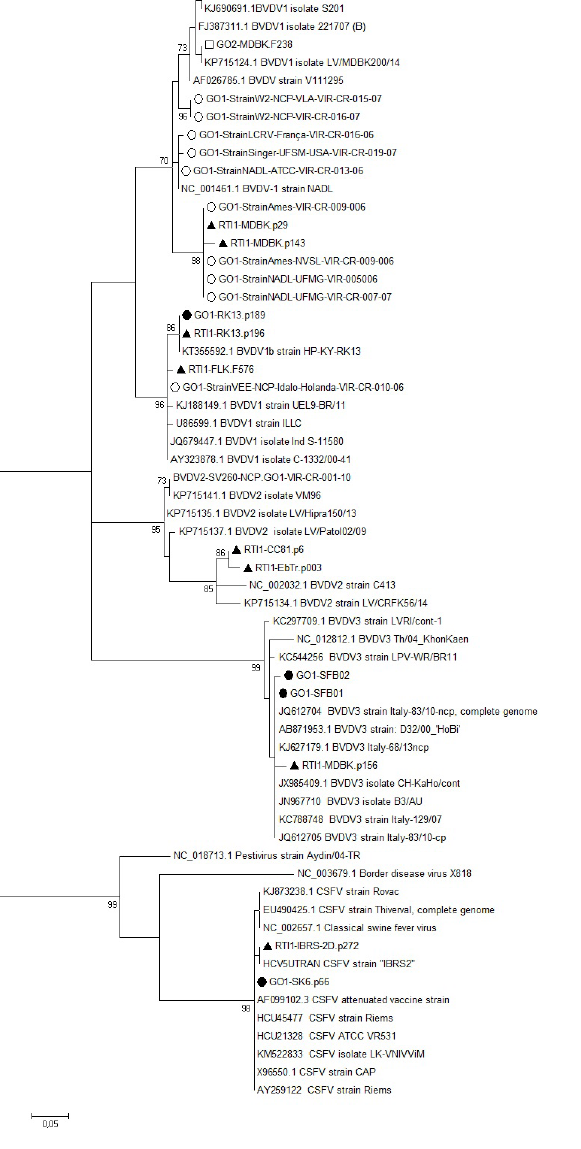
Figure 2. The evolutionary history by using the Maximum Likelihood method based on the Kimura 2-parameter model. The tree with the highest log likelihood (-887,5220) is shown. The percentage of trees in which the associated taxa clustered together is shown next to the branches. Initial tree(s) for the heuristic search were obtained automatically by applying Neighbor-Join and BioNJ algorithms to a matrix of pairwise distances estimated using the Maximum Composite Likelihood (MCL) approach, and then selecting the topology with superior log likelihood value. A discrete Gamma distribution was used to model evolutionary rate differences among sites (5 categories (+ G , parameter = 0,8912)). The tree is drawn to scale, with branch lengths measured in the number of substitutions per site. The analysis involved 62 nucleotide sequences. Sequences from Pestivirus detected in □ cell lines from GO2 ▲ cell lines from RT1 ● cell lines and CSF from GO1 ○ reference strains from